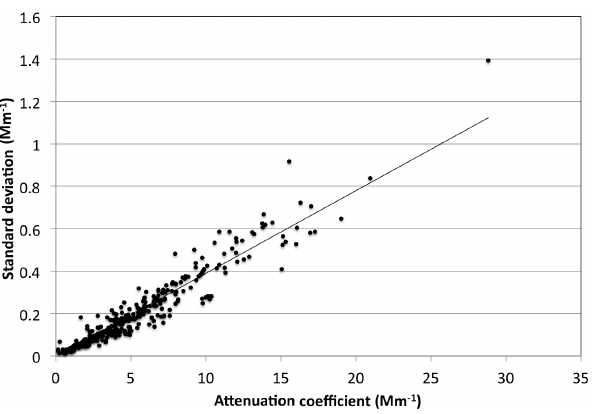
Figure 5. Standard deviation of the attenuation coefficient measured by nine CLAPs (1h averages, 529nm wavelength). The line indi- cates the slope of the regression, forced through the origin. Table 2. Precision of the CLAP attenuation coefficients for 1min and 1h averaging times.